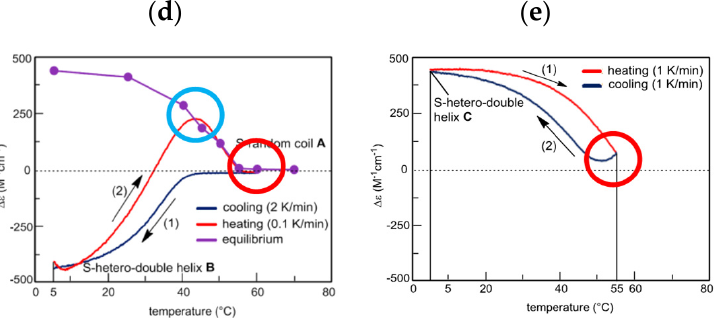
Figure 17. ( a ) Thermal hysteresis of ( P )– 7 and ( M )– 8 in fluorobenzene (0.5 mM) after cooling and heating between 70 ◦ C and 5 ◦ C. ( b ) Slow cooling at an average rate of 0.043 K min − 1 (purple line). For comparison, results in (a) are reproduced. ( c ) Sigmoidal kinetics of chemical reaction 2 A (A) → B (A) at 40 ◦ C [66]. ( d ) Thermal hysteresis between 60 ◦ C and 5 ◦ C during cooling at a rate of 2 K min − 1 and heating at a rate of 0.1 K m –1 . ( e ) Thermal hysteresis between 55 ◦ C and 5 ◦ C by heating and cooling at a rate of 1 K min − 1 . Red bold line indicates bistability. Blue circle indicates specific temperature during heating. Red circles indicate effects of temperature range by a difference of 5 ◦ C. Reproduced from ref. [65] with permission of the American Chemical Society.